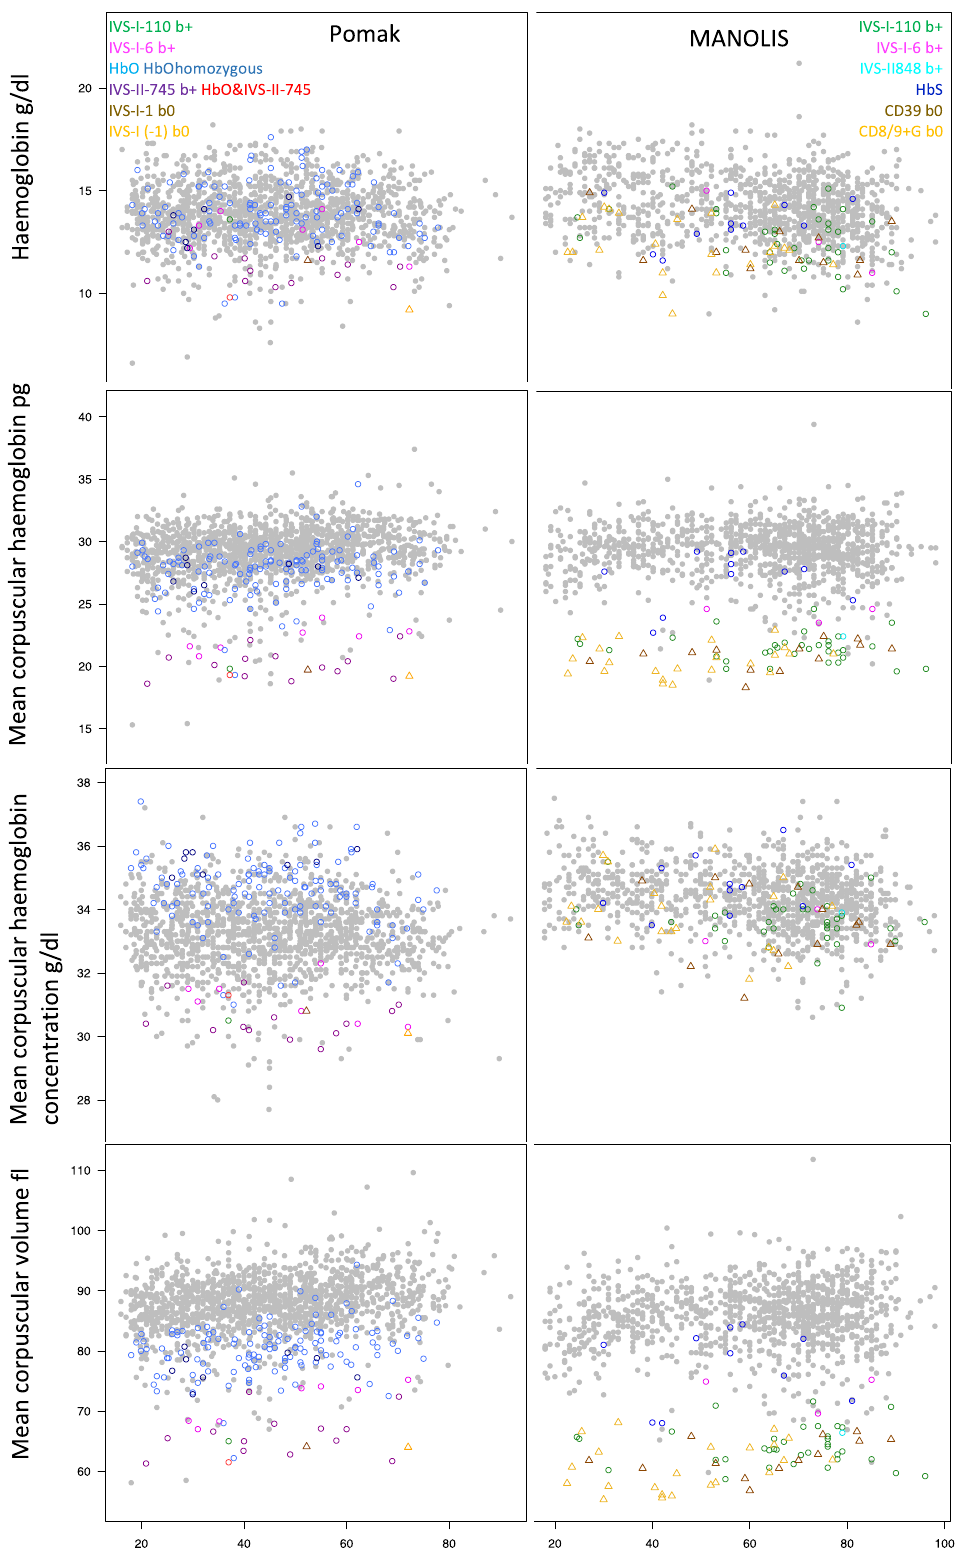
Figure 2. Values for different red cell traits (y-axis) by age (x-axis) for carriers of different HBB mutations in Pomak and MANOLIS. Individuals without a detected HBB mutation are shown as grey points. Values for carriers of particular mutations are shown using different colours as indicated on the